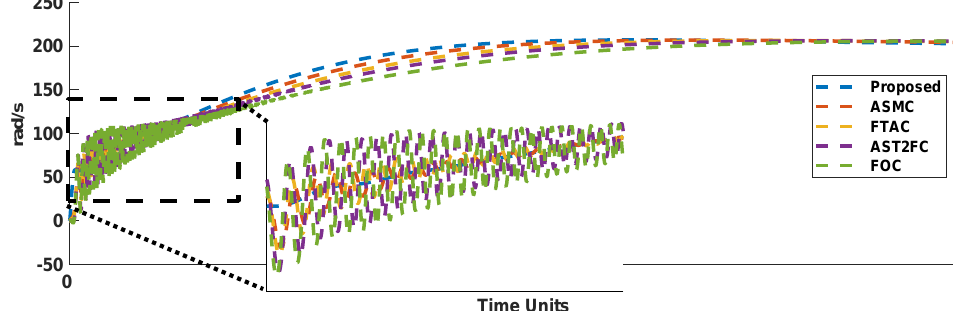
Figure 14. Output trajectory with various